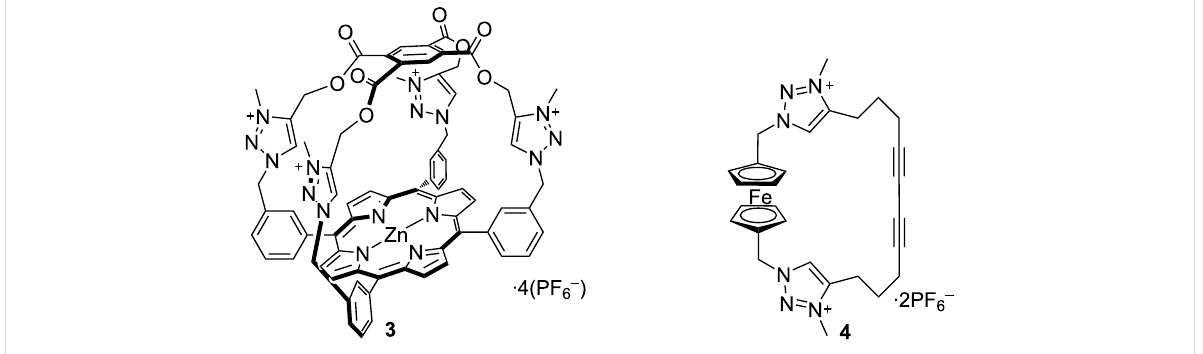
Figure 4: Chemical structure of compound 3 and 4